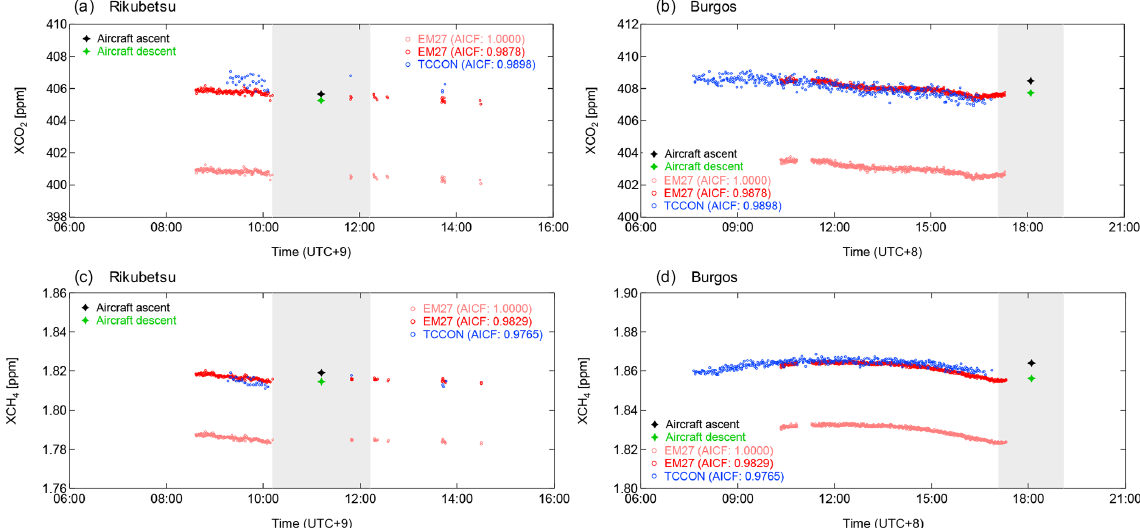
Figure 5. (a, b) XCO 2 and (c, d) XCH 4 values measured by the EM27/SUN, TCCON, and airborne instruments over (a, c) Rikubetsu on 27 April 2016 and (b, d) Burgos on 12 March 2018. The aircraft XCO 2 and XCH 4 values are calculated separately for the descending (green) and ascending (black) profiles shown in Figs. 1 and 3. Shown are the EM27/SUN values without air-mass-independent correction factors (AICFs = 1) and with them (AICFs ∼= 1). The EM27/SUN data within the light gray shaded areas indicate ± 1h of the aircraft measurements and are used for determining the AICFs.